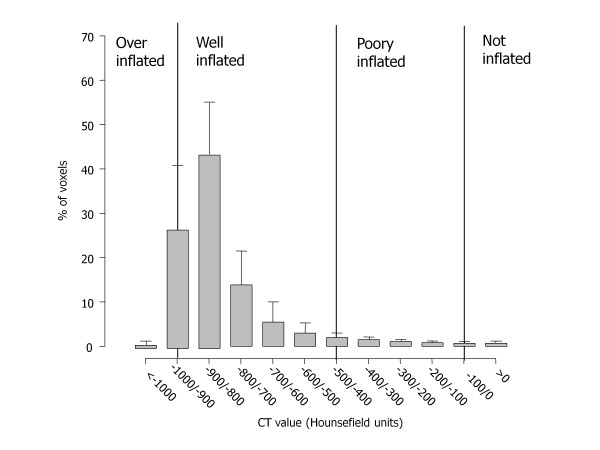
Frequency distribution of Hounsfield unit numbers. Frequency distribution of attenuation divided into intervals of 50 Hounsfield units (HU). Vertical lines indicate the ranges of lung inflation used in the literature: overinflated, between -1,000 and -901 HU; well aerated, between -900 and -501 HU; poorly aerated, between -500 and -101 HU; not aerated, <-100 HU. Note that frequency distribution refers to volume and not to weight. CT, computed tomography